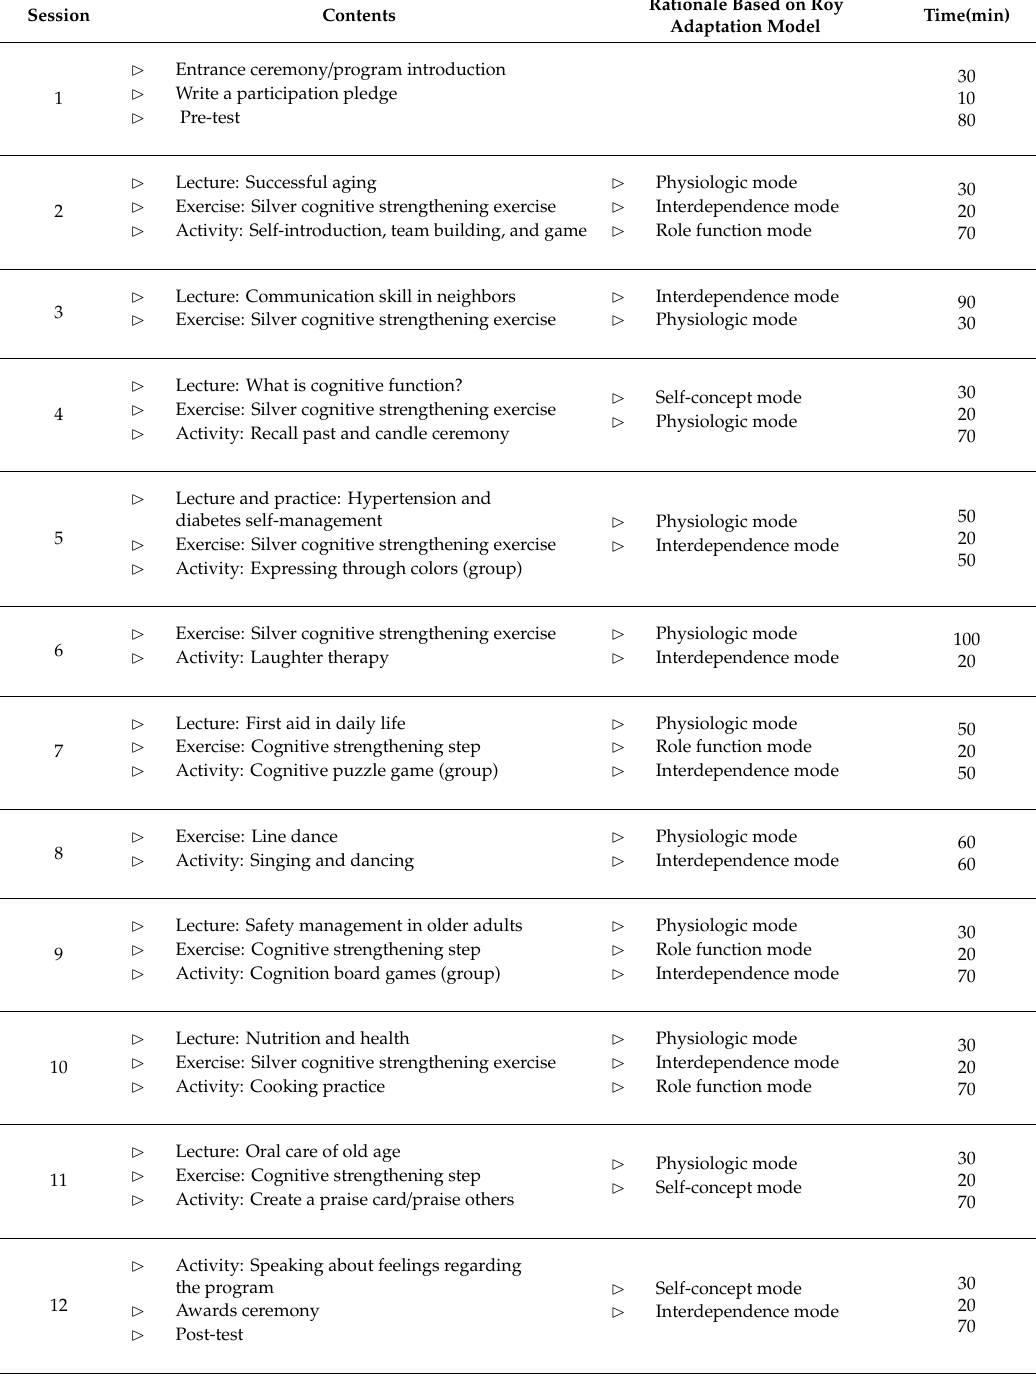
Table 1. Integrated healthcare program for older adults based on the Roy Adaptation